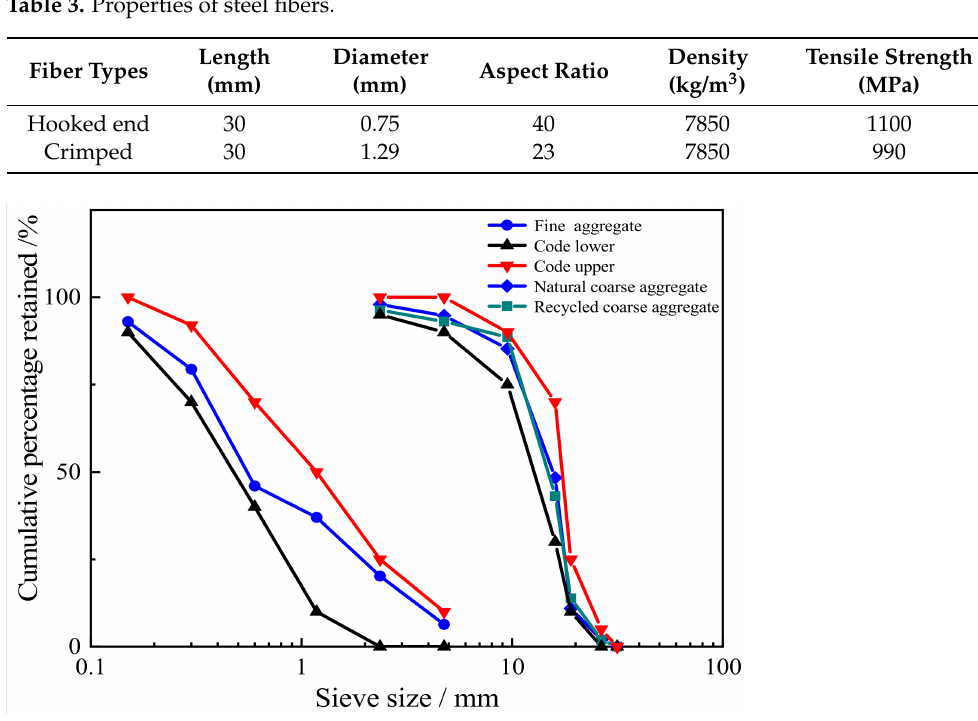
Table 3. Properties of steel fibers.